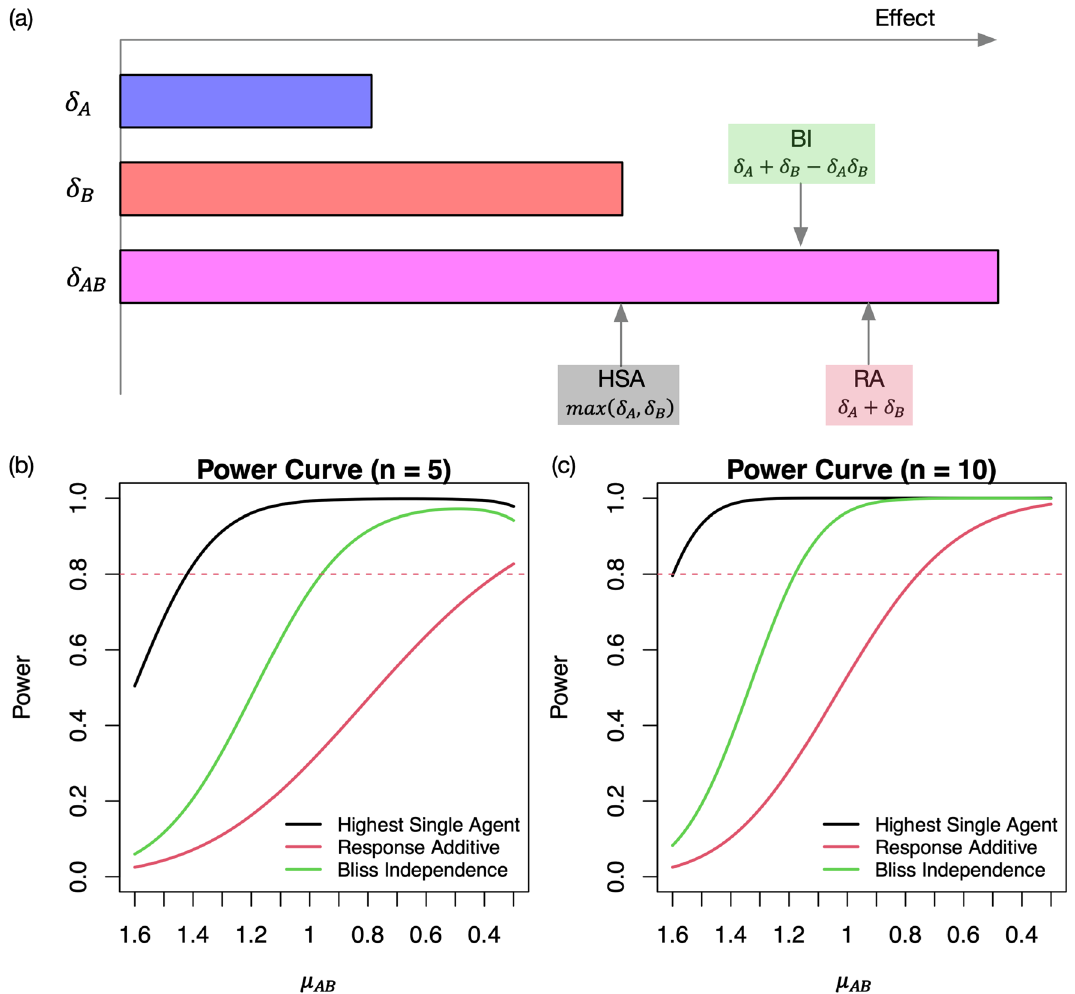
Figure 4. Comparison of HSA, BI and RA models under the hypothetical scenario where µ C = 2.8, µ A = 2.4 and µ B = 2 . ( a ) Given δ A and δ B , the arrows indicate the minimum δ AB values that have synergistic effects ( CI > 0 ) . ( b , c ) Statistical power varies by the mean tumor volume for the combination AB when the sample size is 5 and 10 at the 0.05 significance level. The standard errors of relative tumor volumes are set to 0.7 for the control group C and 0.3 for the treatment groups A, B and